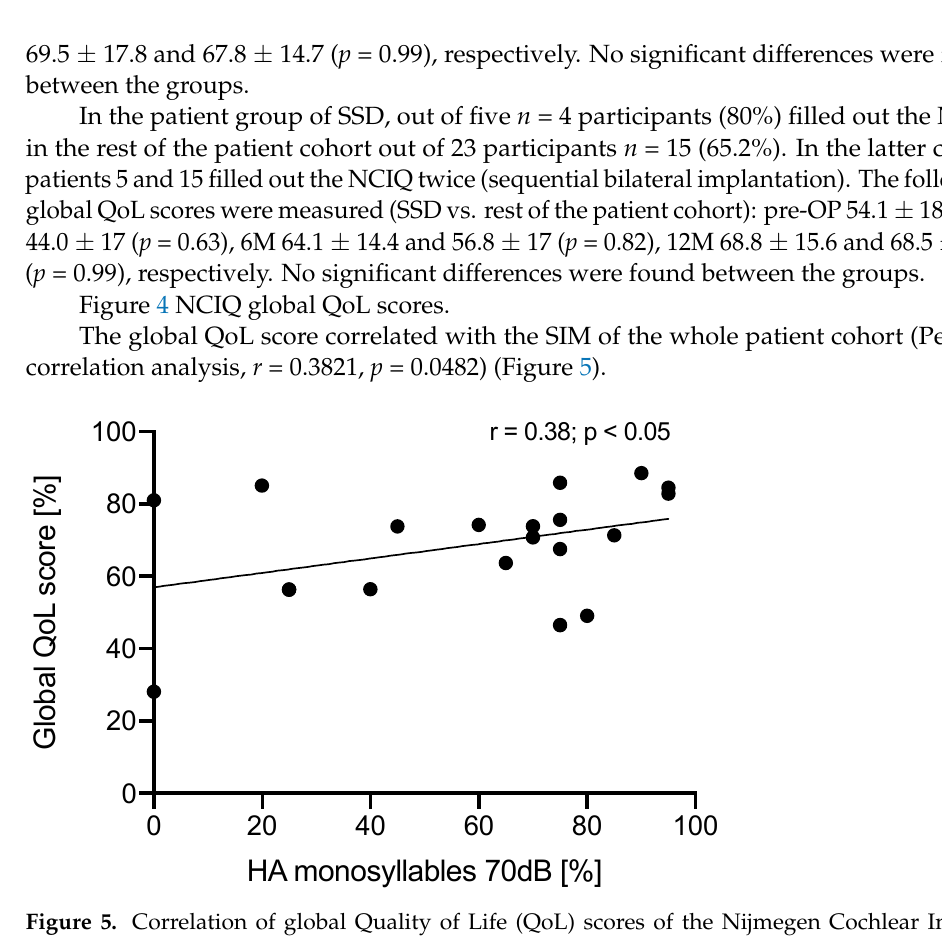
Figure 5. Correlation of global Quality of Life (QoL) scores of the Nijmegen Cochlear Implant Questionnaire with the CI-aided (HA) speech understanding at 70 dB SPL (Freiburger monosyllable test) postoperatively at 12 months. Figure 5 Correlation of SIM and NCIQ global QoL